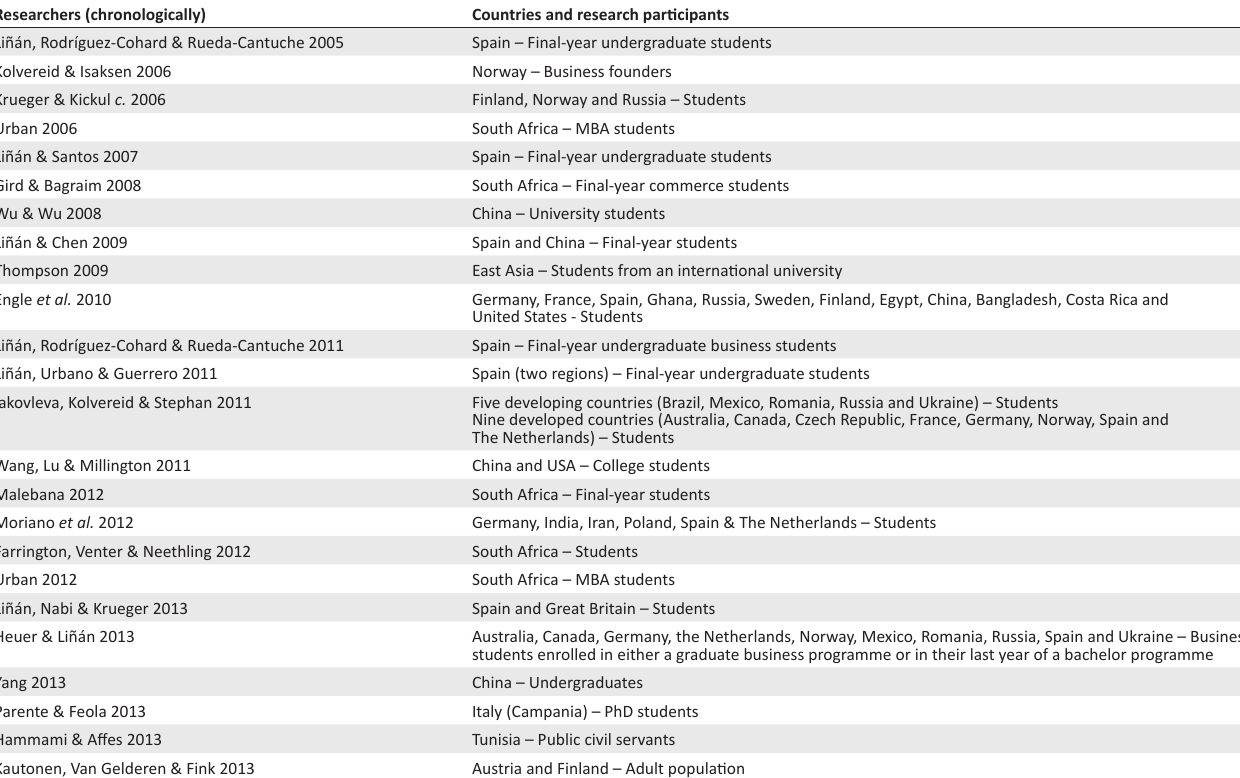
TABLE 3: Research on entrepreneurial intent by